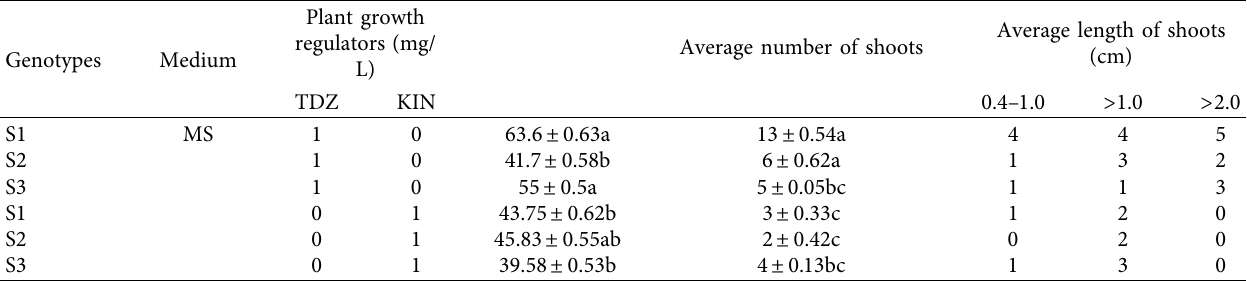
Table 3: Proliferation rate, average number, and length of “Beldi” almond ecotype shoots on MS medium in the presence of TDZ and KIN.